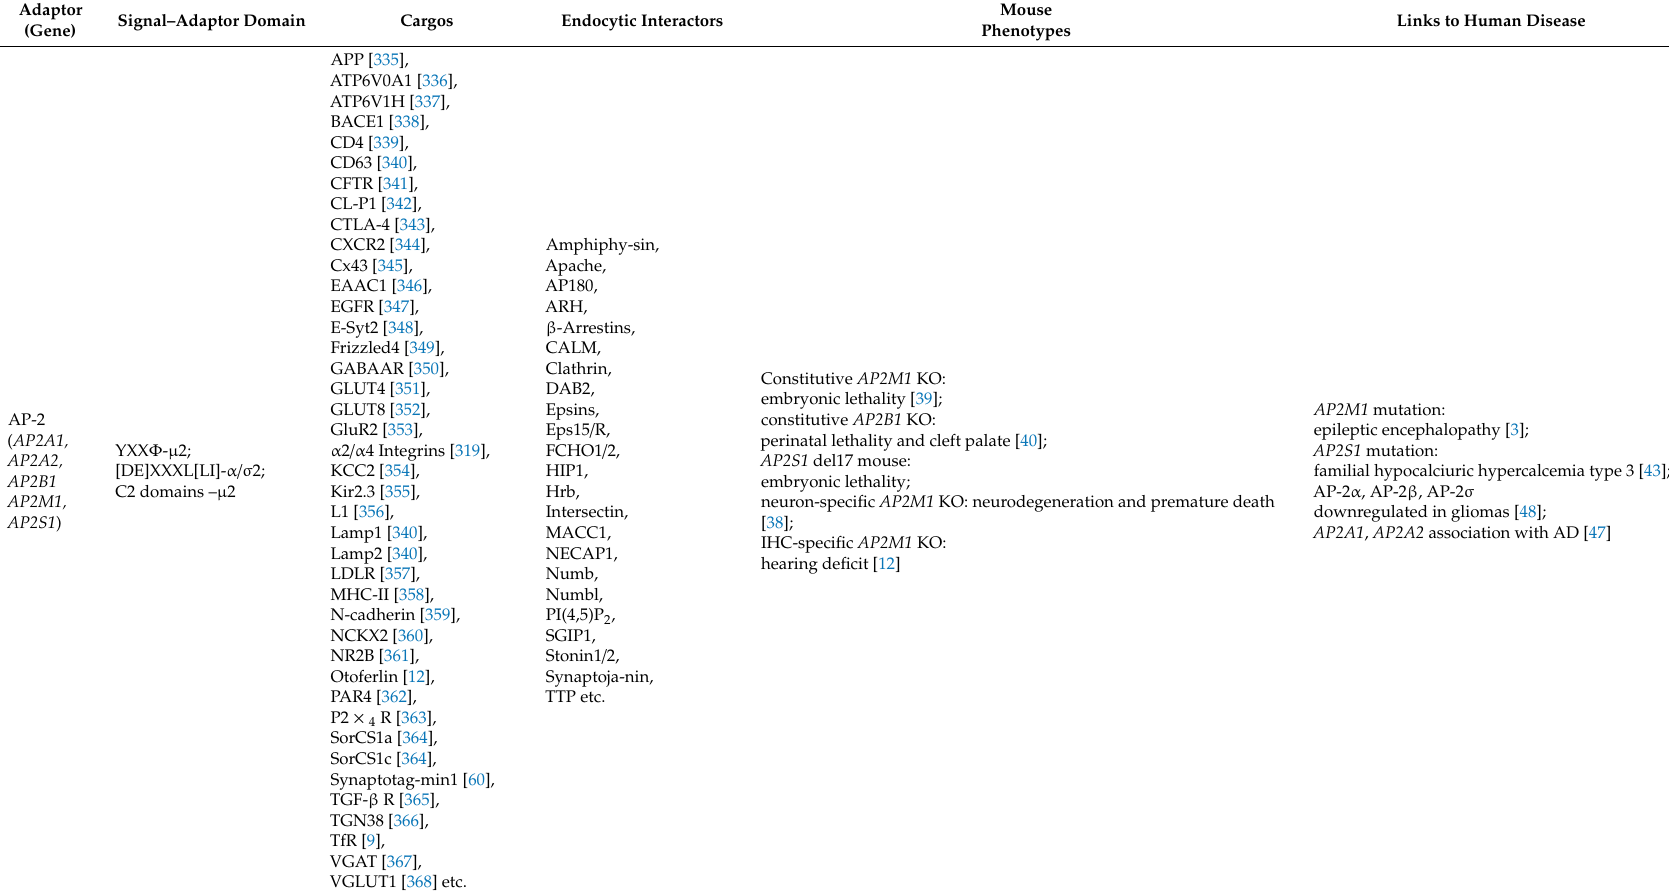
Table 1. Overview of cargo recognition and physiological relevance of endocytic adaptors. Abbreviations are explained in the list of abbreviations. Adaptor